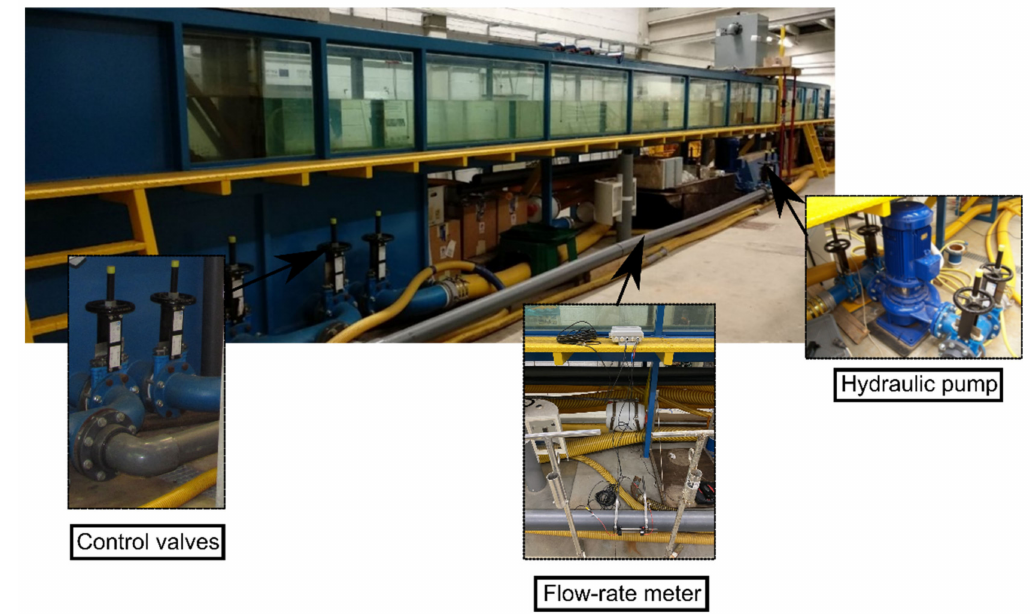
Figure 4. Water-current flume with the hydraulic control